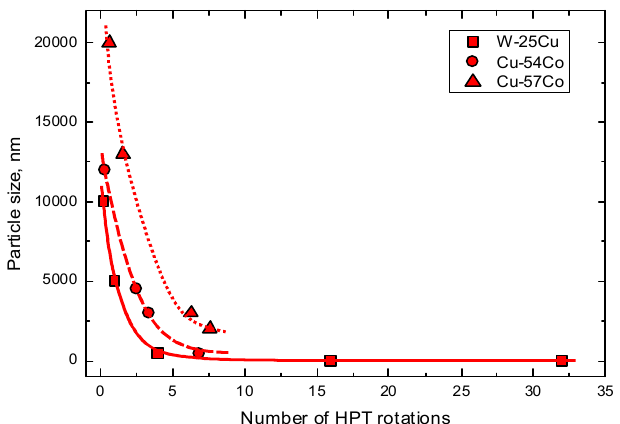
Figure 6. The dependence of particle size of on the number of HPT rotations. The size of W particles in the W—25 wt.% Cu alloy (solid red squares) was estimated from the data published in ref. [81]. The size of Co particles in the Cu—54 at.% Co alloy (solid red circles) and Cu—75 at.% Co alloy (solid red triangles) was estimated from the data published in refs. [82,83]. The lines are the guides for the eye.